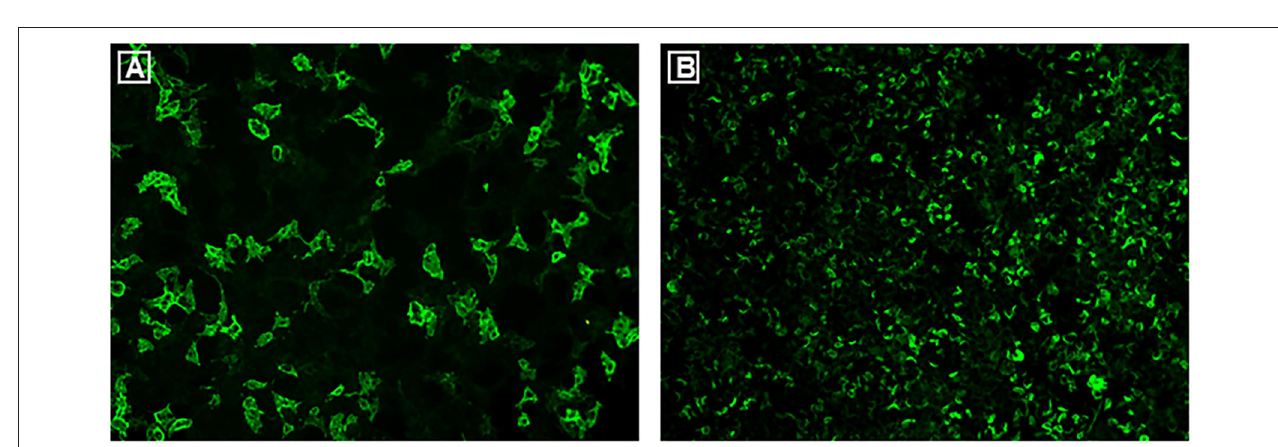
FIGURE 2 | Axial (A) and coronal (B) MRI scans of optic nerves showed bilateral atrophy.